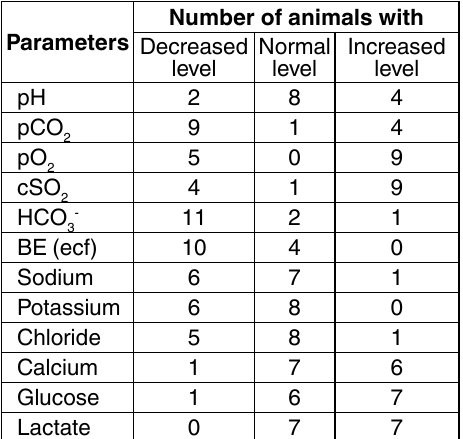
parameters and biochemical parameters were analysed and represented in Tables 4, 5 and 6. table 4. Number of CPV infected dogs with various alterations in blood gases, electrolytes and metabolites